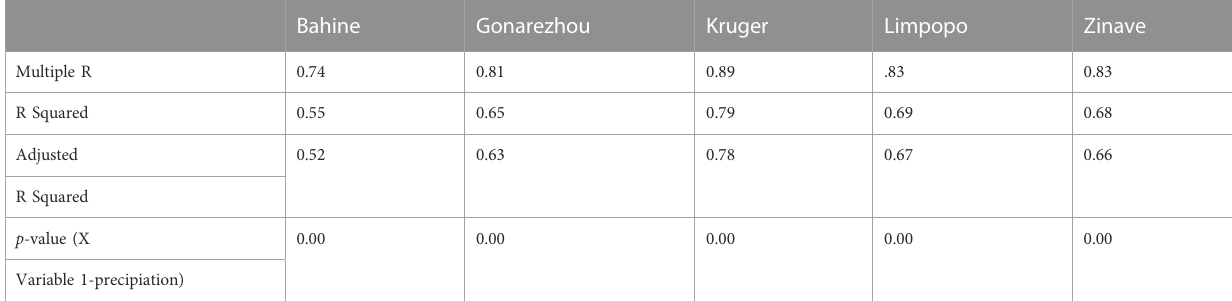
TABLE 5 Regression statistic results from Figure 8 ( n =